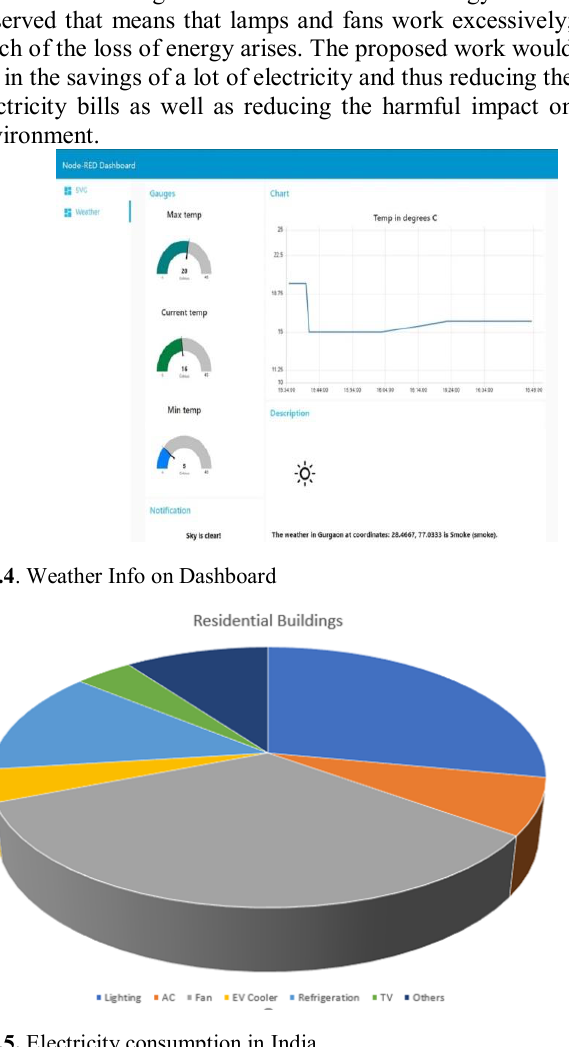
Fig.5. Electricity consumption in